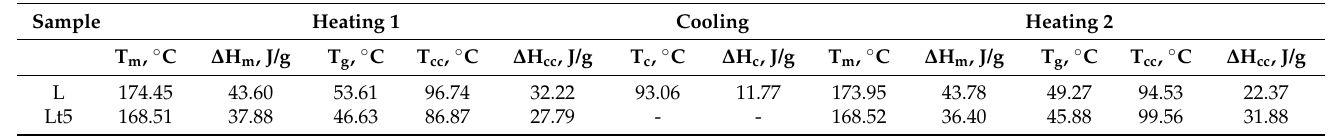
Table 2. Thermal property test results determined by the DSC method; all symbols are explained in the text.